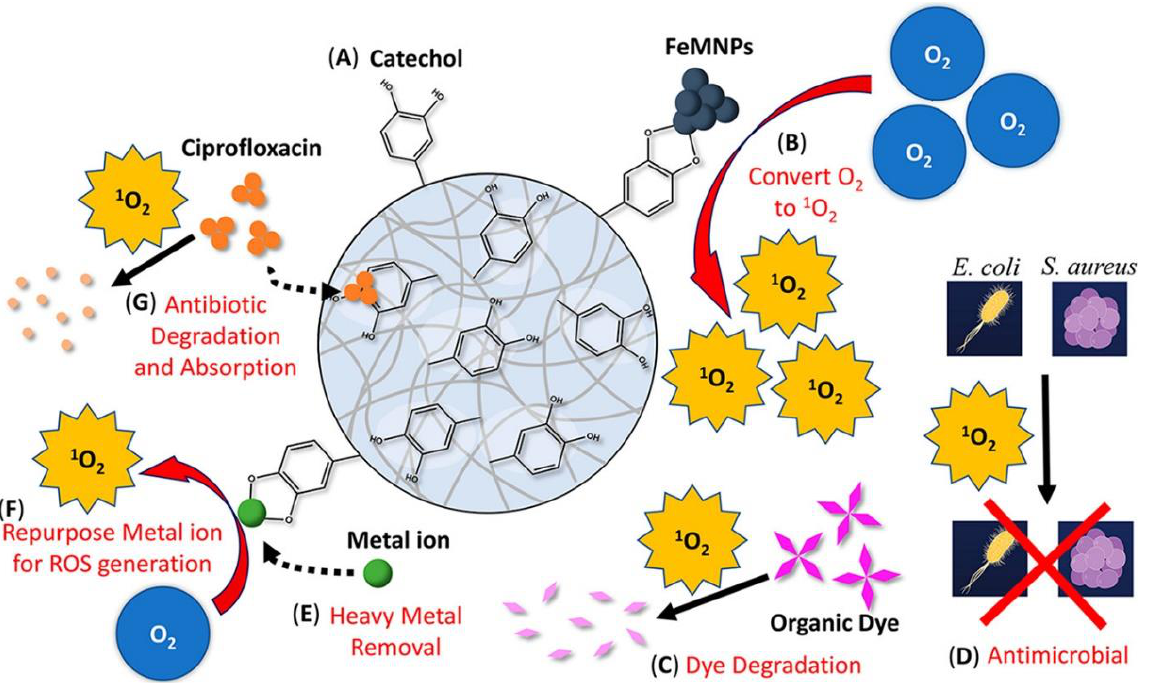
Figure 7. Multifunctional catechol-based microgel. Reprinted with permission from reference [88], copyright 2020 American Chemical Society.